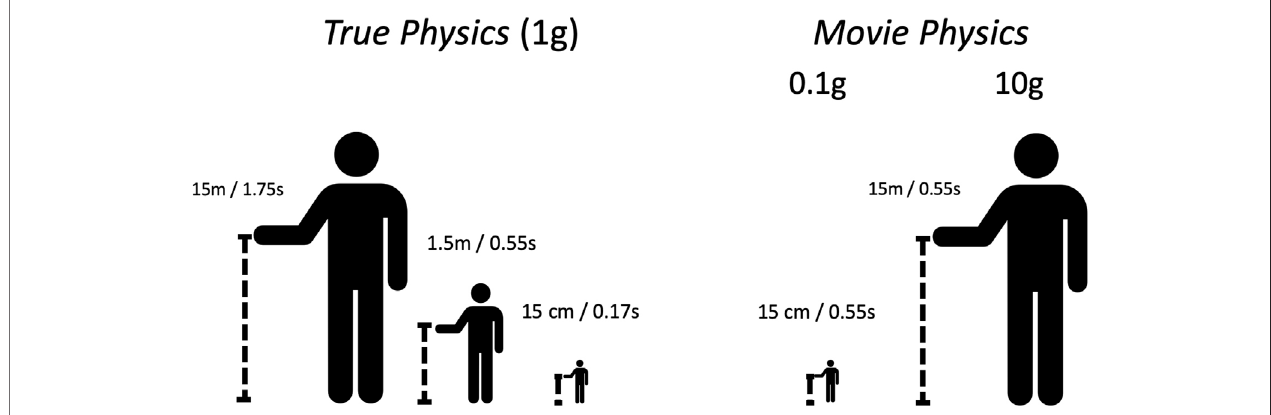
FIGURE 1 | A fi gure depicting conditions reported by Pouke et al. (2021) to illustrate the relationship between gravity and scale among various pairs. In the true physics condition, gravity behaved realistically at each scale (left). In the movie physics conditions, gravity was manipulated so that free-fall speeds of objects (and rigid body dynamics in general) matched that of human height, regardless of scale